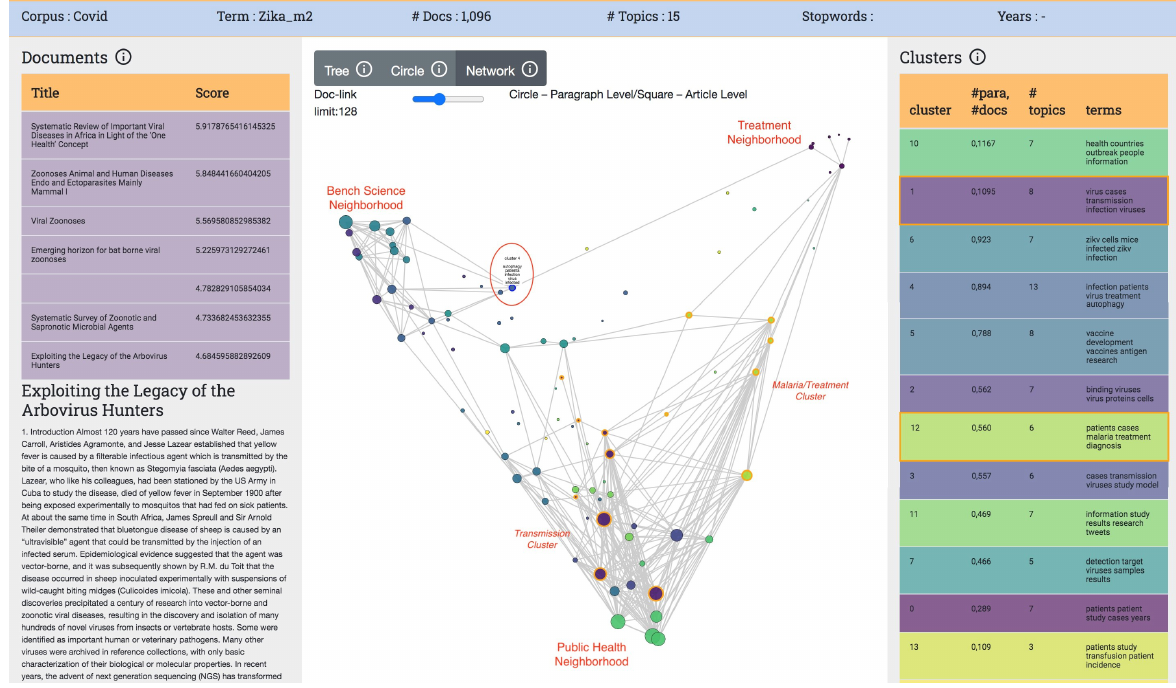
Figure 9. Network visualization of the Zika Topic